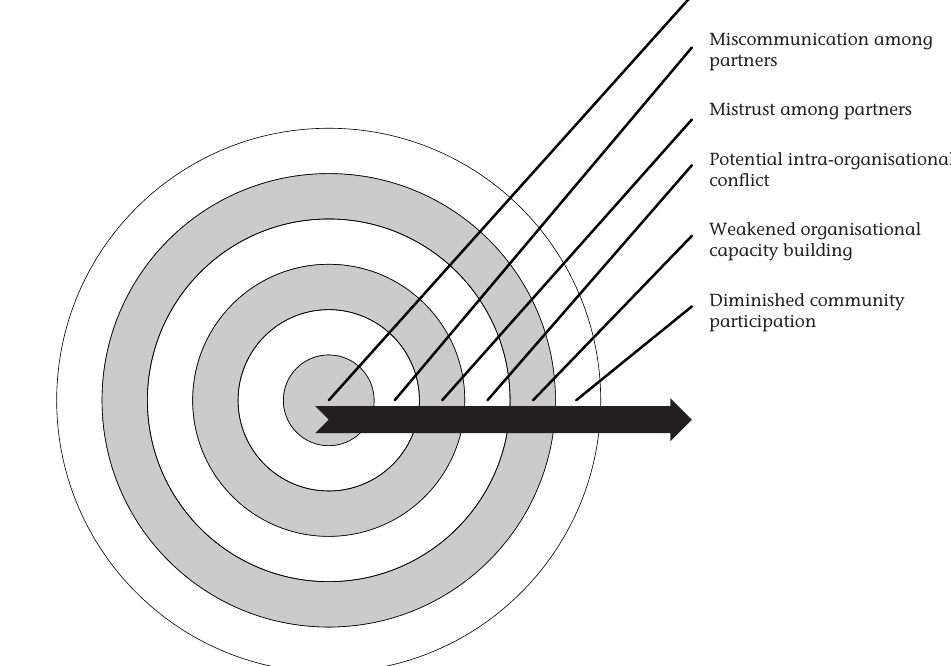
Figure 3: ‘Ripple Effect’ when threshold dimensions are not